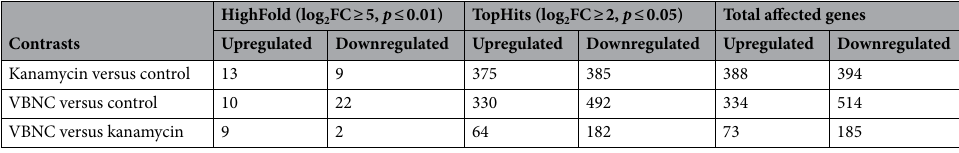
Table 2. Differently expressed genes in tested conditions.